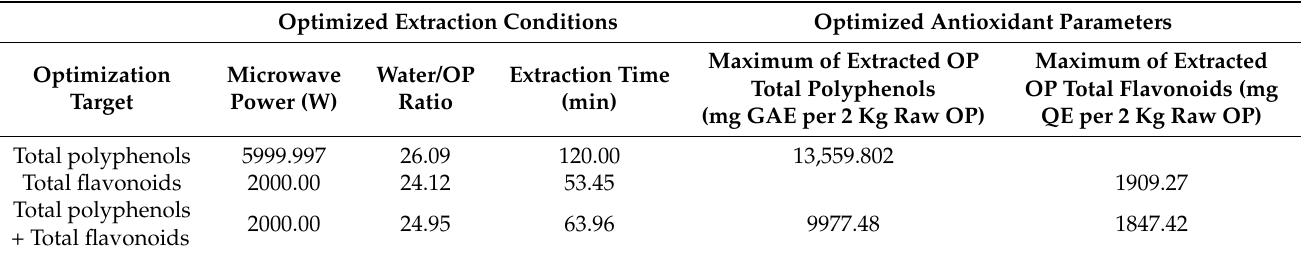
Table 4. Optimum (maximum) values of antioxidant parameters of OP extracts vs. VMAE parameters. Optimized Extraction